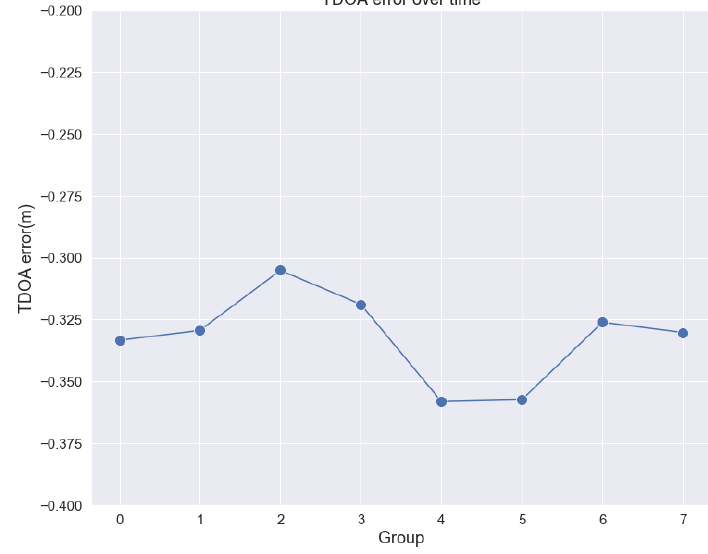
Figure 9. Fluctuation of the average TDOA error in disturbed